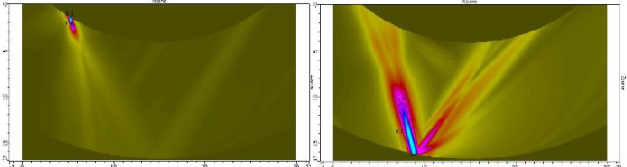
Fig. 12. Beam profiles: 10 MHz, 8x8mm rectangular probe, spherical focus r=10 mm (left) and 25 mm (right).